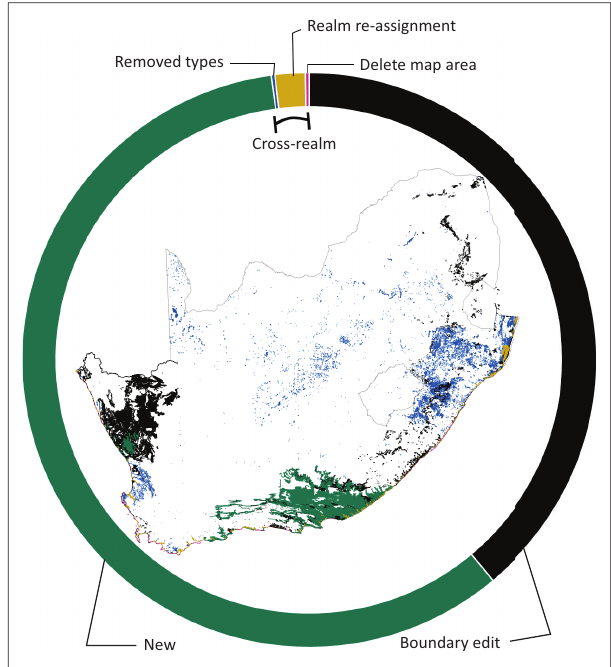
FIGURE 1: Distribution of the five categories of changes and proportion contributed by each category to the cumulative area changed in the National Vegetation Map 2018, with an indication of which changes affected multiple realms. Only the area affected by removed aquatic vegetation types is shown. These polygons are small and have been slightly emphasised in bold so that they are visible in the figure. The position of Albany Thicket vegetation types that were replaced by new vegetation types has not been shown as these two categories overlap. Refer to Table 1 for details of the change